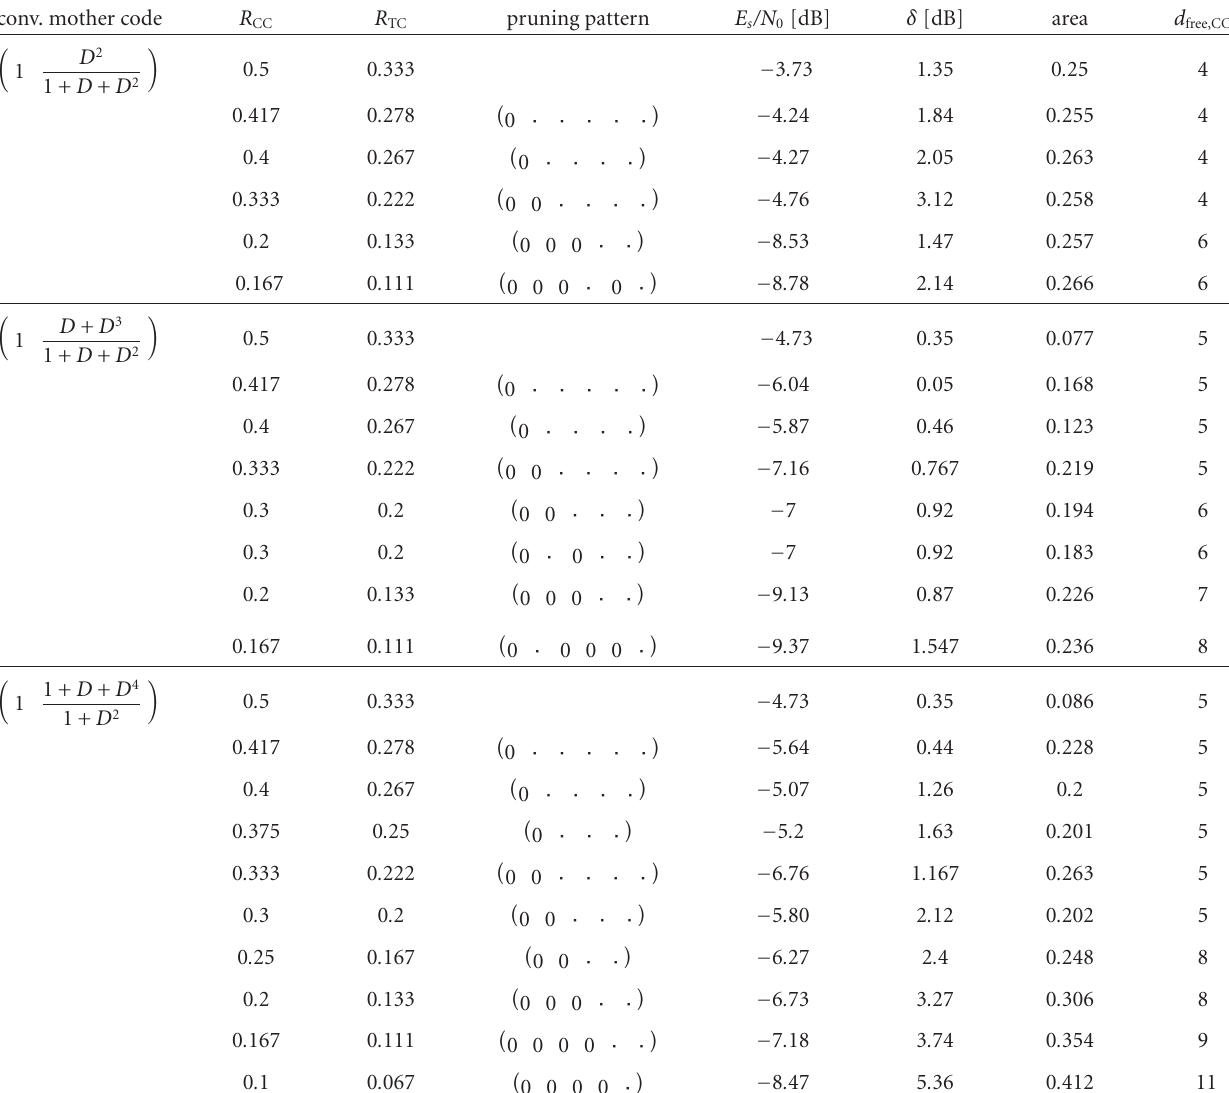
Table 2: List of good codes with constraint length L c = { 3,4,5 } and rate-1/2 convolutional mother code. Given are the code rates R CC and R TC of the corresponding convolutional and Turbo code, the pruning pattern, the SNR (dB) where the Turbo code converges, the o ff set δ from the Shannon limit (dB), the area between the EXIT curves, and the minimum distance of the convolutional code d free,CC . conv. mother